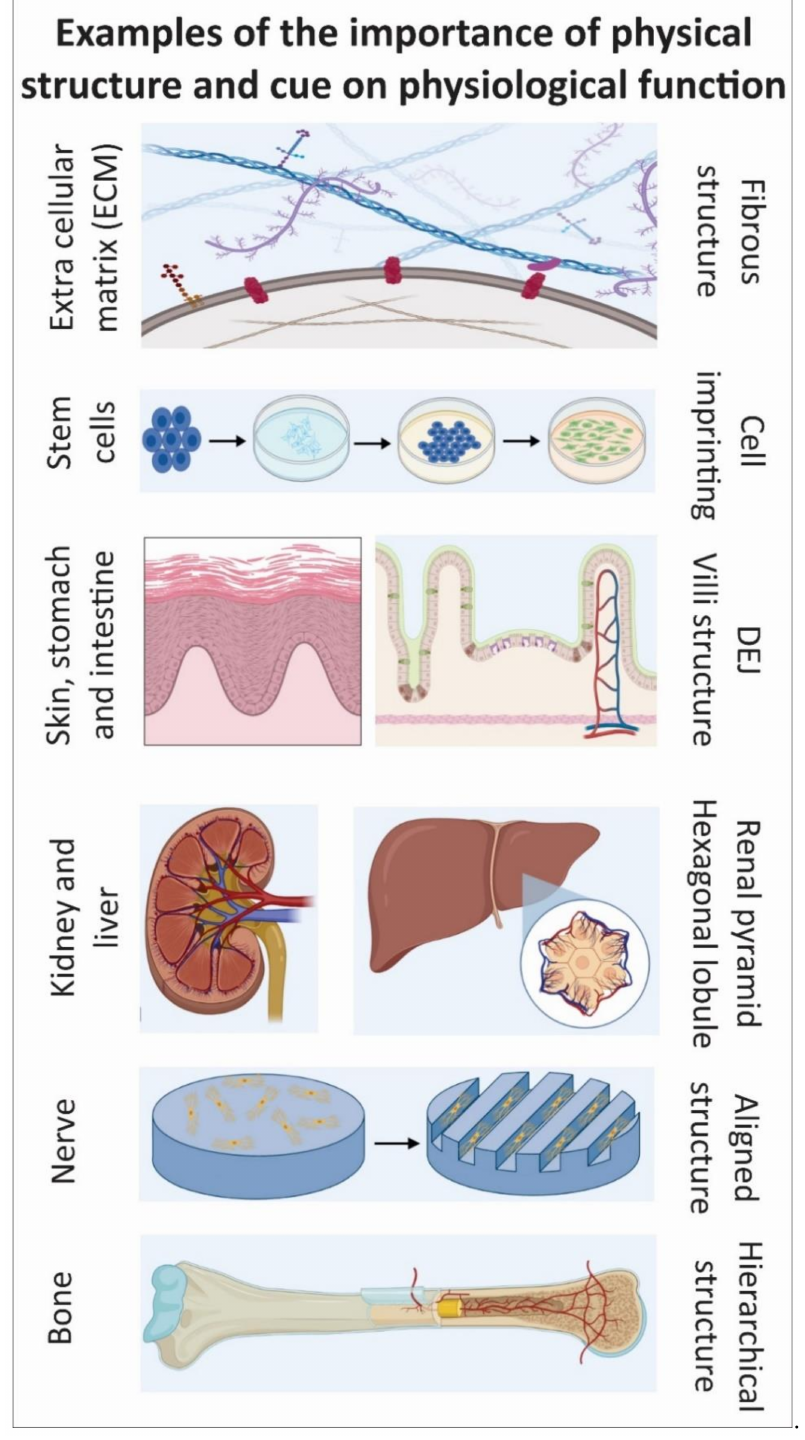
Figure 9. Graphical conclusion—The importance of physical structure on physiological